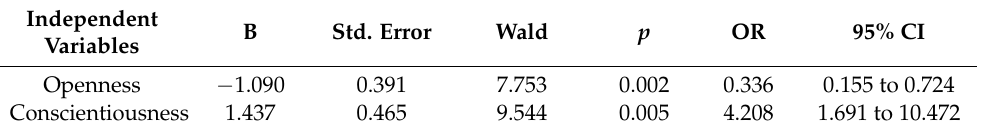
Table 3. Logistic regression performed between openness and conscientiousness dimensions and